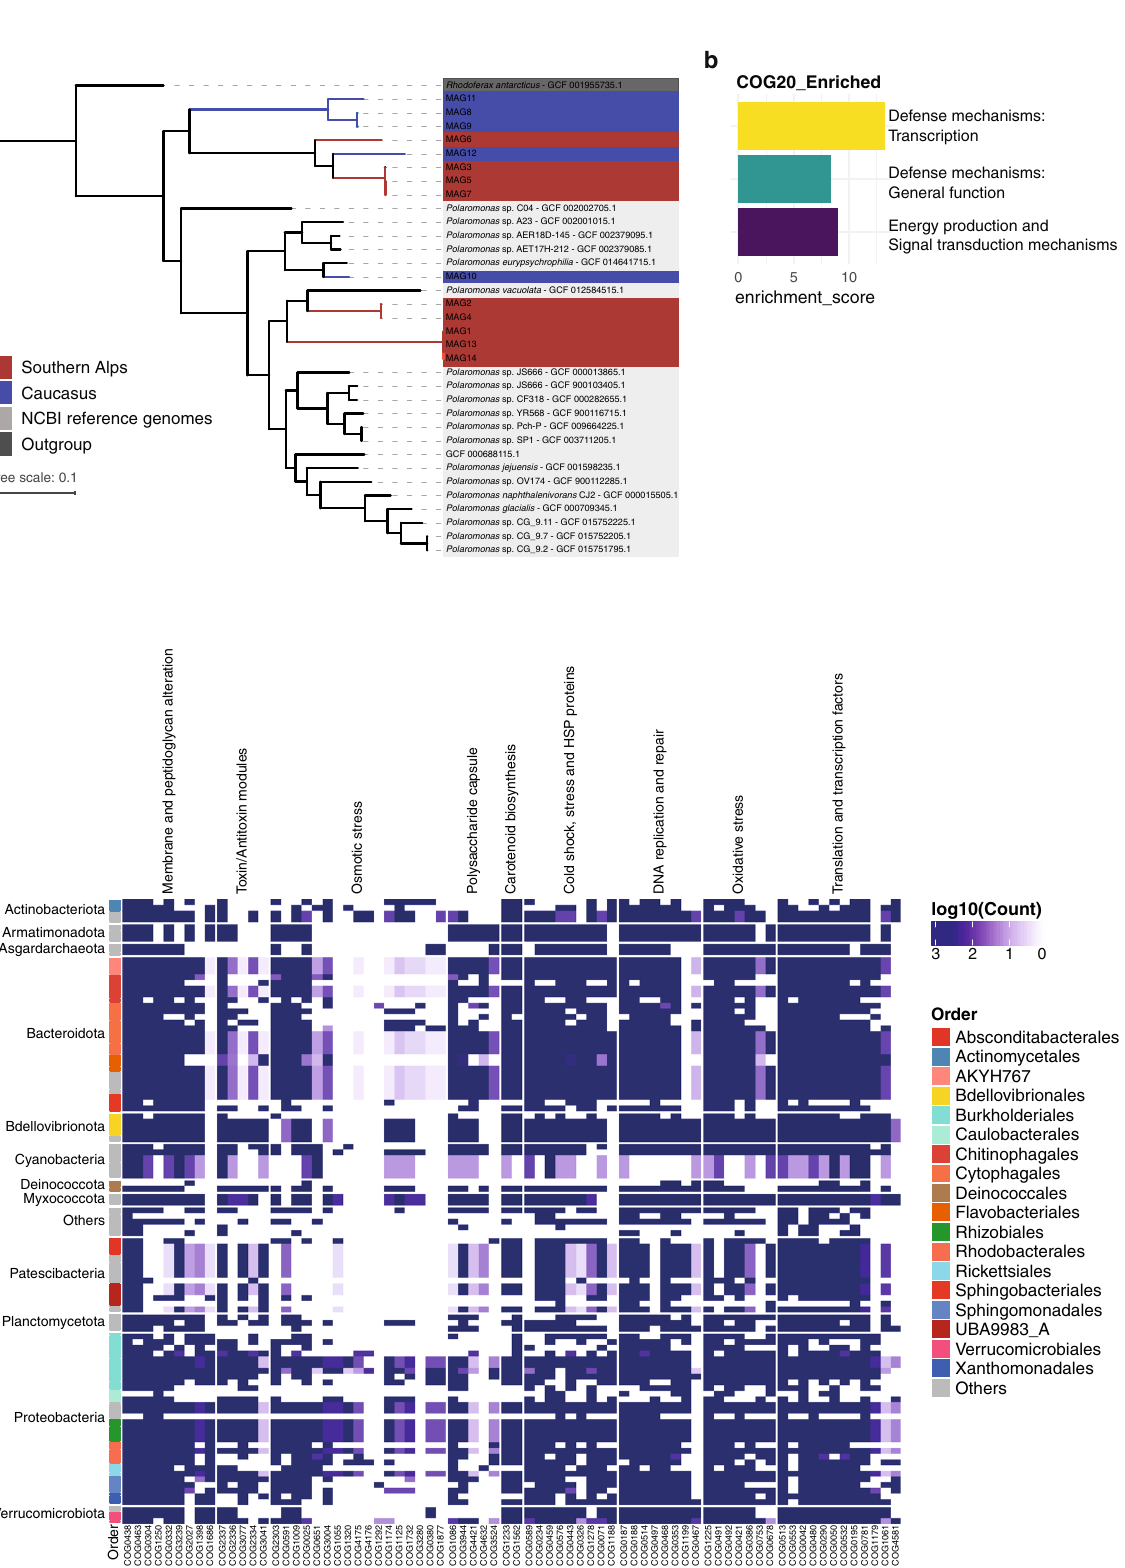
Fig. 5 Genomic underpinnings of adaptation to the extreme GFS environment. a Phylogenomic tree based on Polaromonas genomes recovered from Southern Alps (red) and Caucasus (blue) along with publicly available genomes (grey) and an outgroup ( Rhodoferax , dark grey). b Clusters of orthologous (COG20) group pathways enriched in epilithic bio fi lms MAGs compared to the reference genomes are depicted in the barplot. c Heatmap representing the abundance of genes involved in cold adaptation. Taxonomy at phylum and order levels is depicted. Columns indicate clusters of orthologous groups associated with adaptive